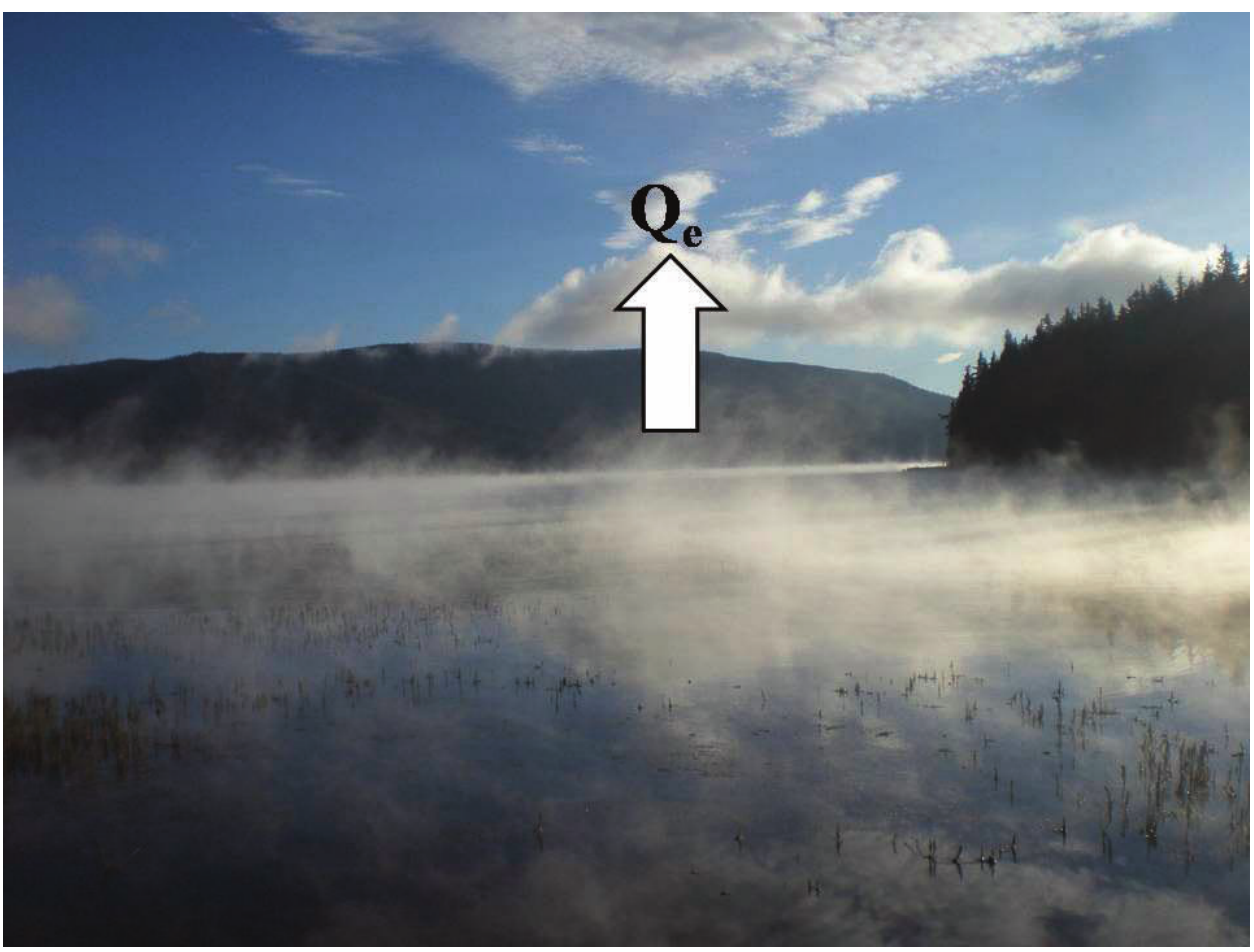
Figure 4. Evaporation (Q ) from Paulina Lake, Newberry Caldera, Oregon, USA (August 2010; photograph: D. Rouwet). The lake temperature was ~18 ˚C, e while the ambient temperature was ~5